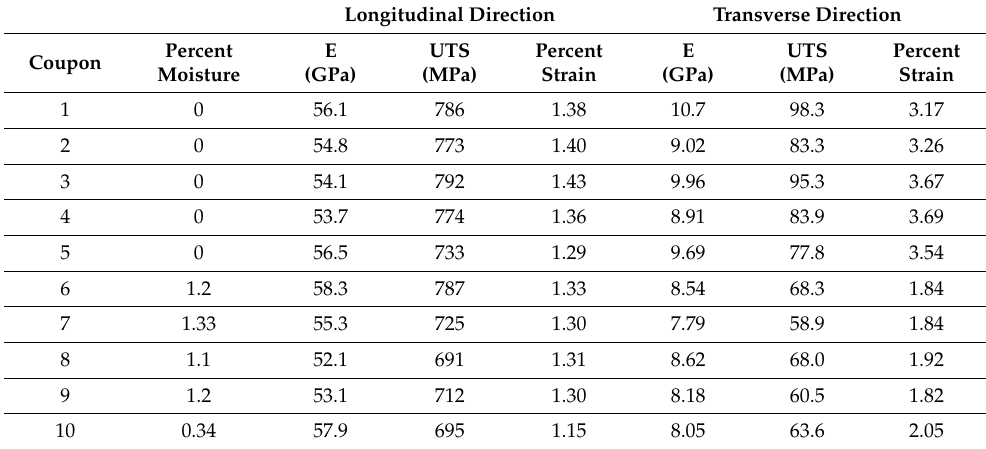
Table 4. Tensile test results for dry and moisture saturated test coupons.